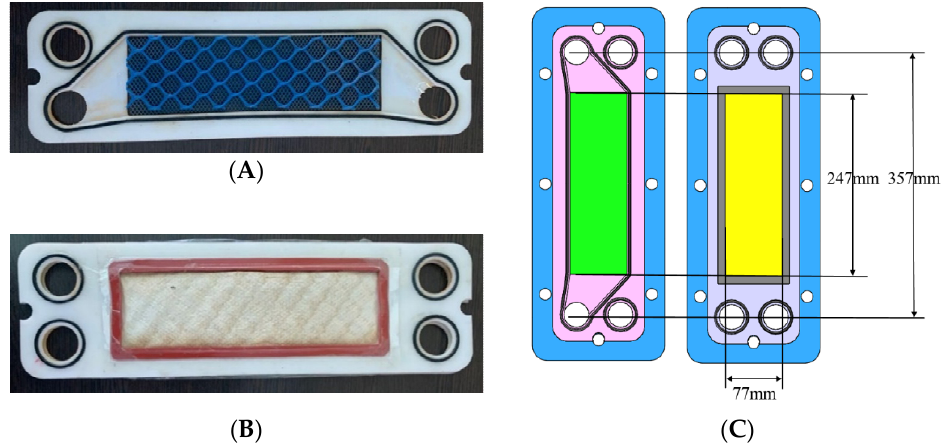
Figure 3. The plates: ( A ) channel plate, ( B ) membrane plate; ( C ) the schematic with its dimensions.